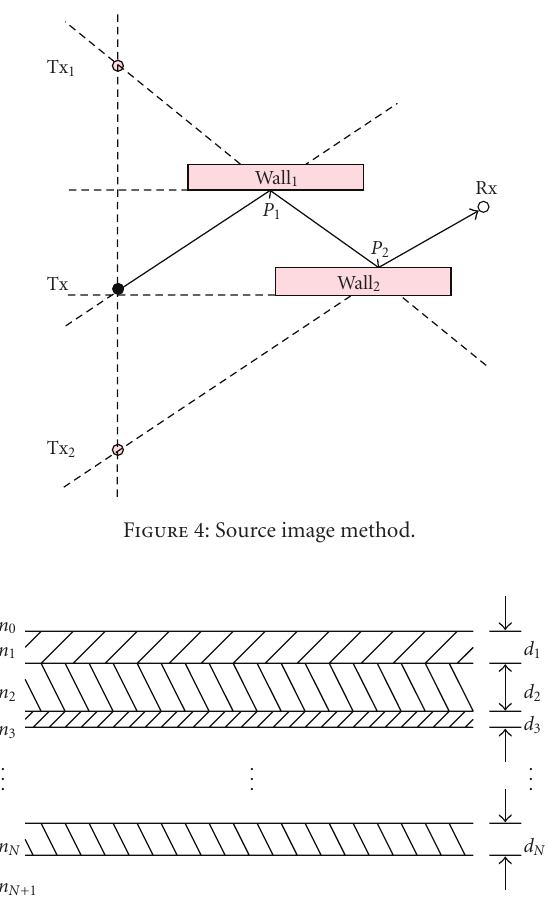
Figure 5: Multilayered structure. n i and d i are the complex refractive index and the thickness of the i th layer,